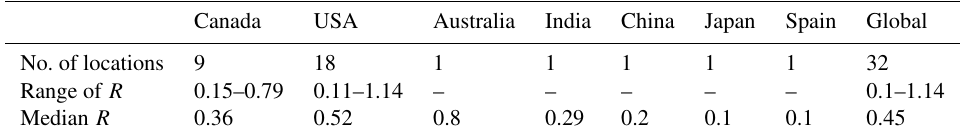
Table 3. Calibrated R in different locations and their median value for temporal downscaling of domestic water